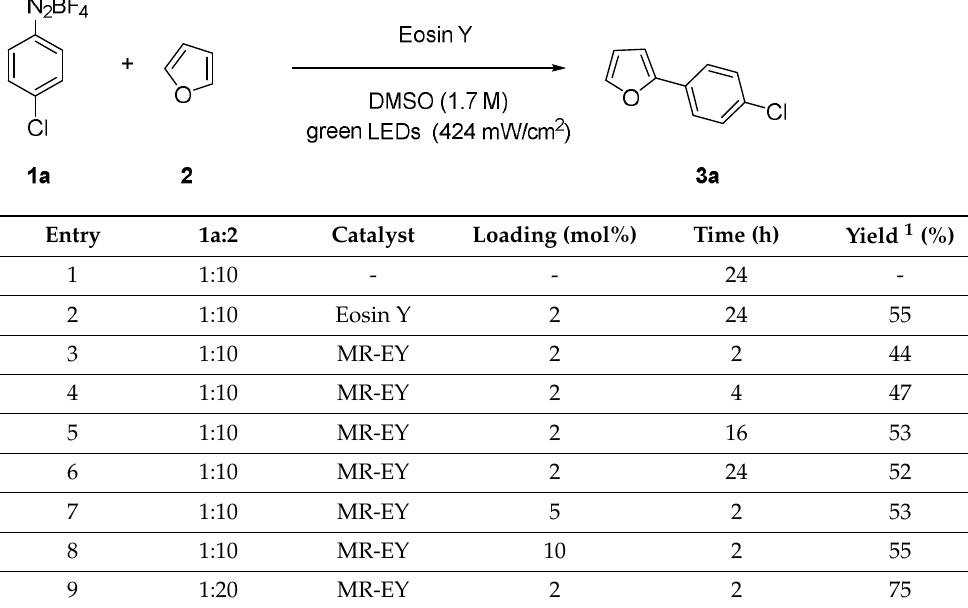
Table 1. Direct arylation of furan 2 with diazonium salt 1a . Reaction conditions screening.